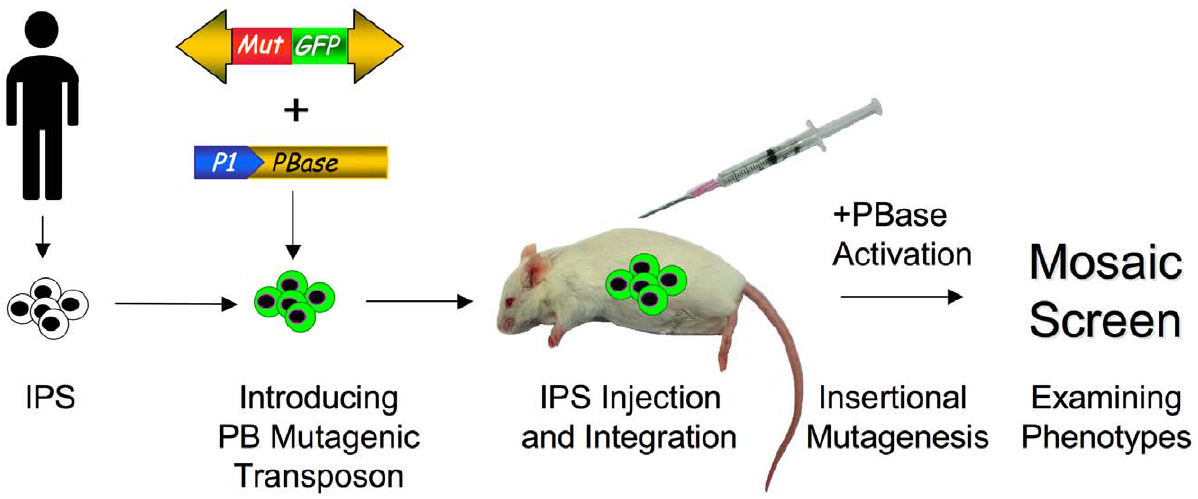
Figure 2. Screening for phenotypes in humanized mice with patient-derived IPS cells. IPS cells are first created from a patient. A mutator transposon containing mutagenic elements (red box) and a GFP marker (green box) and an inducible PBase construct (utilizing the Cre-ER/lox or Tet system) is introduced into patient-derived IPS cells. Green cells indicate GFP expression from the stably integrated mutator transposon(s). The cells are then introduced into the mouse tissue by injection (syringe). Next, transposase activity is induced, which mobilizes the mutagenic transposon, resulting in insertional mutation. Finally, the mice are screened for the desired disease or developmental phenotype.